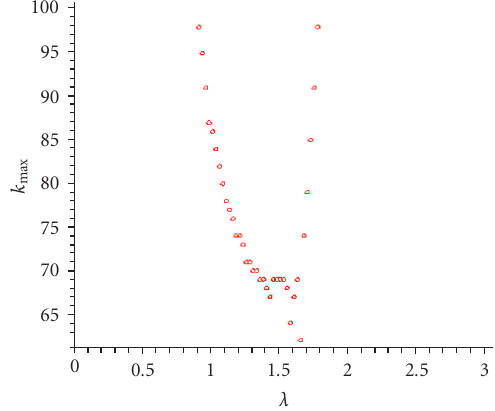
Figure 5.5. Modified Newton algorithm for di ff erent values of λ with x = − 2 . 88418640 × 10 − 8 .